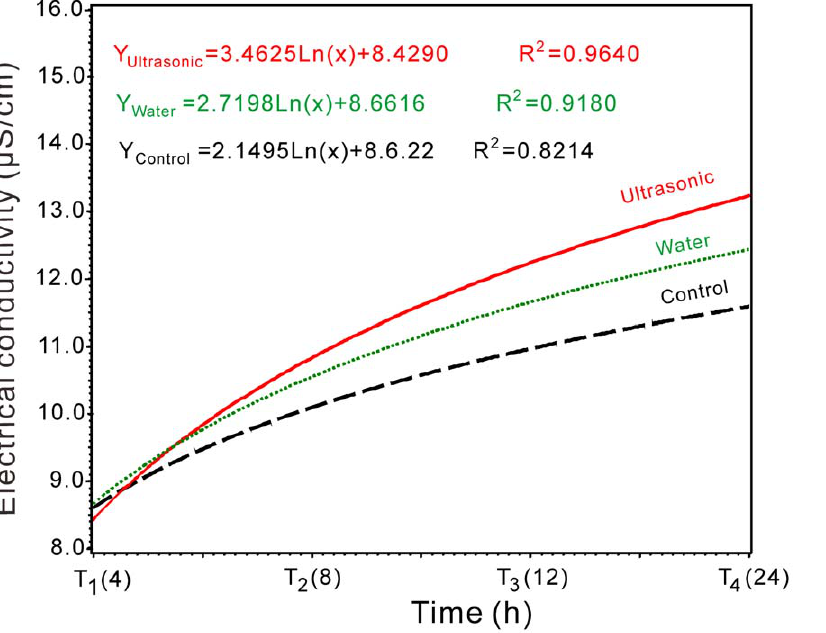
Figure 4. Electrical conductivity of switchgrass seeds soaked in water only (Water), soaked in water in ultrasonic device (Ultrasonic) and without any treatment (Control).